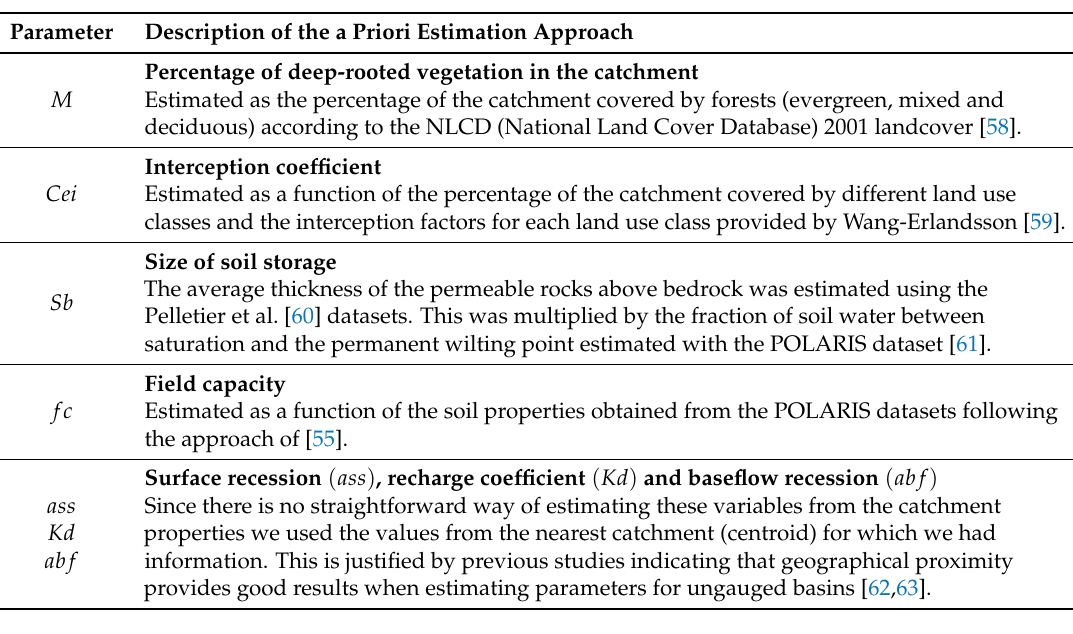
Table 3. Description of the procedure estimating the soil parameters a